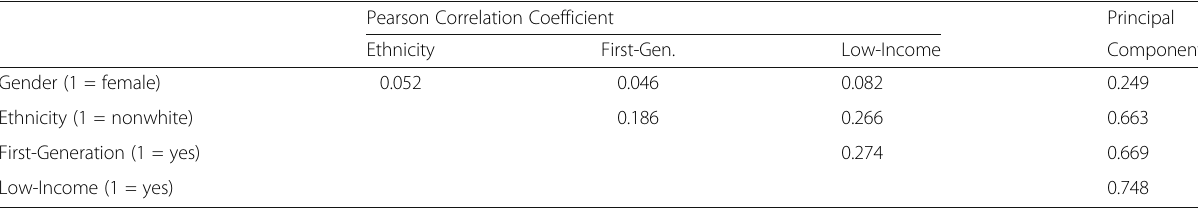
Table 6 Principal component analysis on the four demographic factors in the study. The principal component among these variables explains 37.7% of total variance